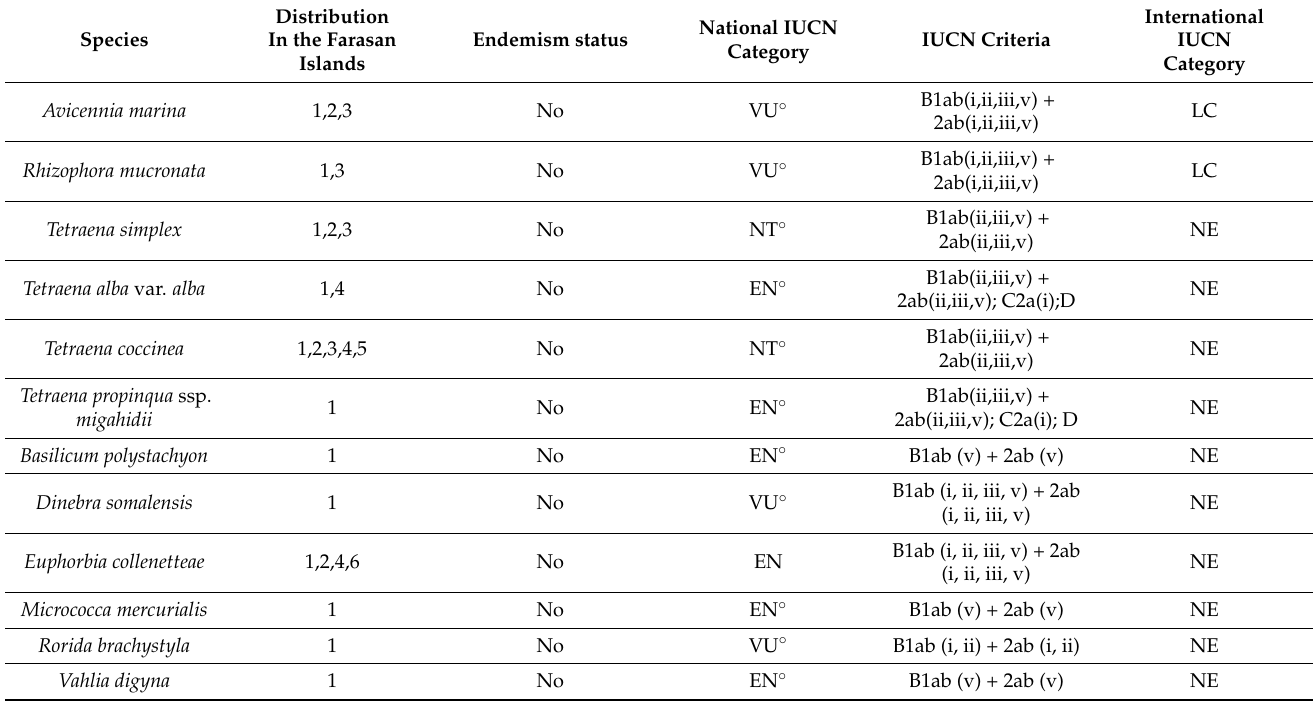
Table 2. Red listing status of the twelve taxa including the taxon name and the distribution of species in the Farasan archipelago: Farasan Alkabir (1), Sajid (2), Zifaf (3), Dawshak (4), Qummah (5), and Dumsuk (6). Endemism status in the islands, national IUCN category, criteria applied and global IUCN category was also